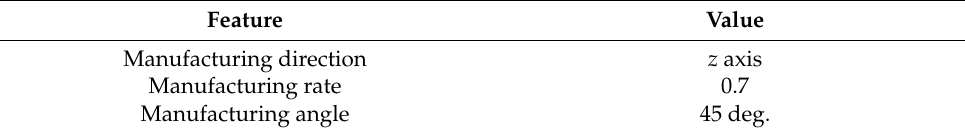
Table 3. Overview of the manufacturing conflict settings chosen for MaSmo.